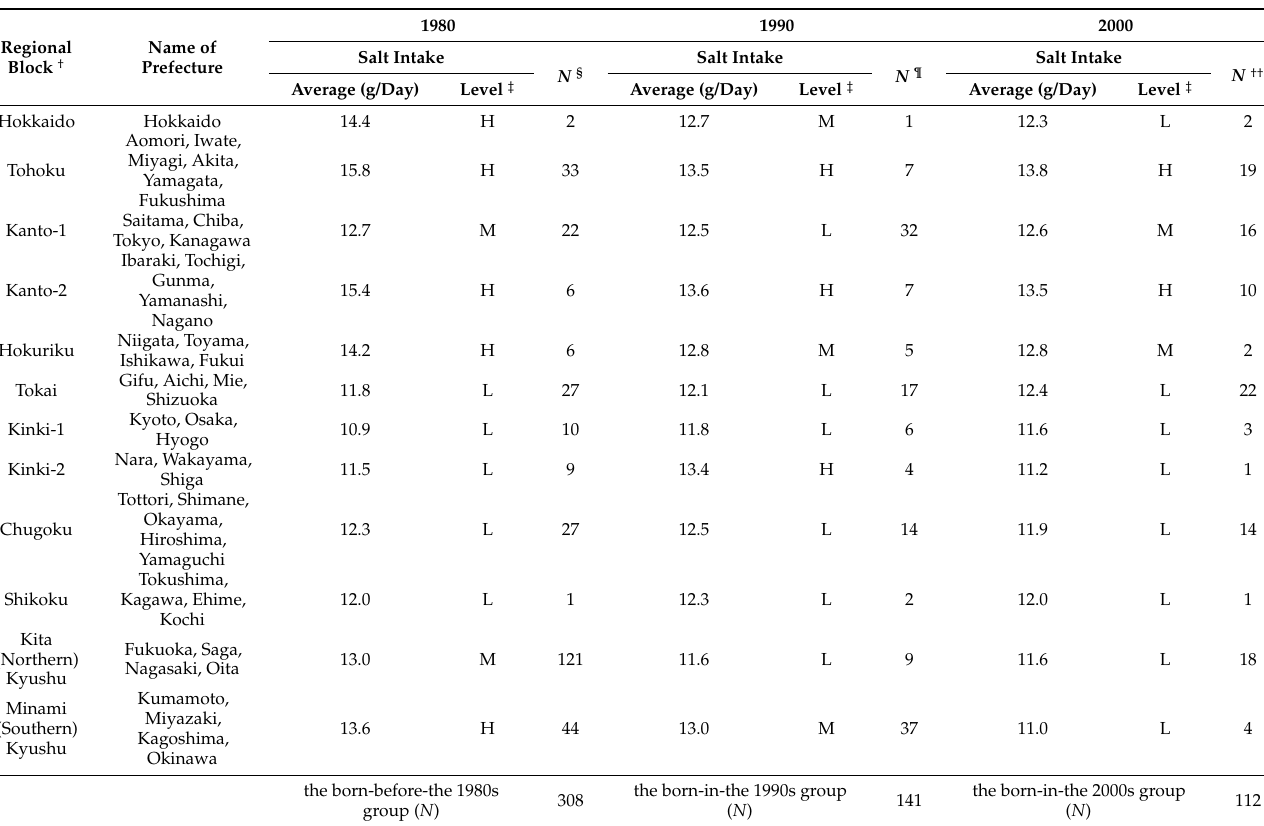
Table 1. The average amount and level of salt intake in 1980, 1990, and 2000 for 12 regional blocks in Japan along with the number of participants born in each regional block.